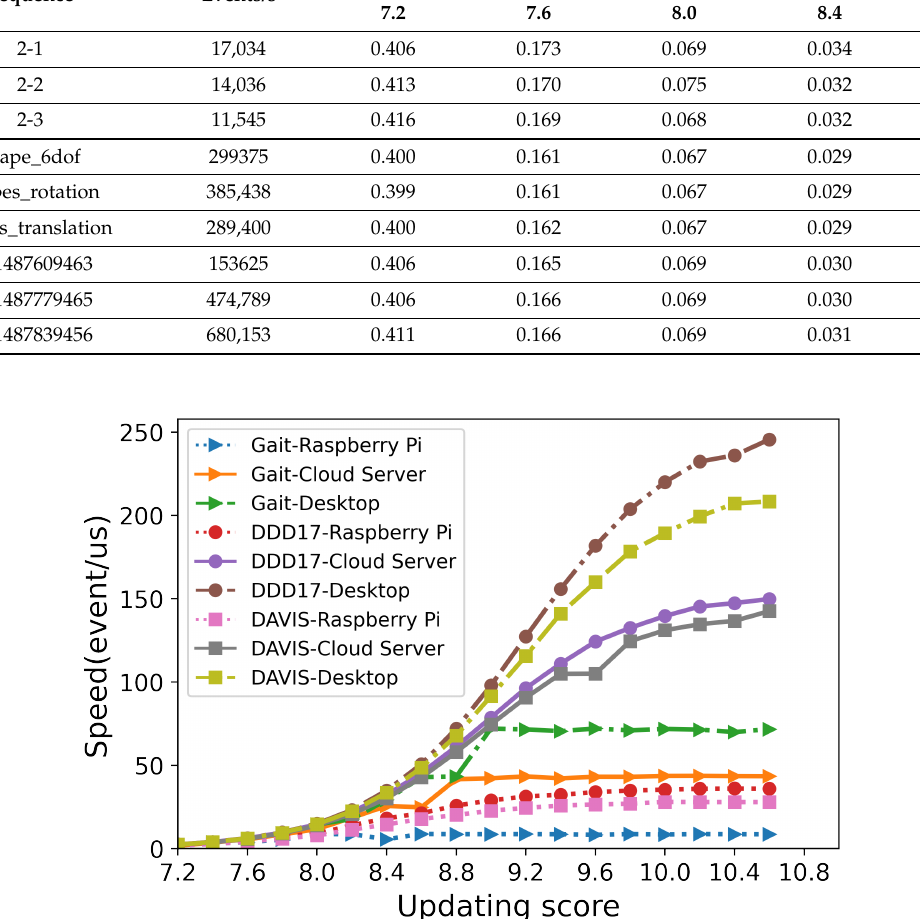
Figure 10. The relationship between the updating score and the number of events processed per second (in µ s) using different NVSs on various